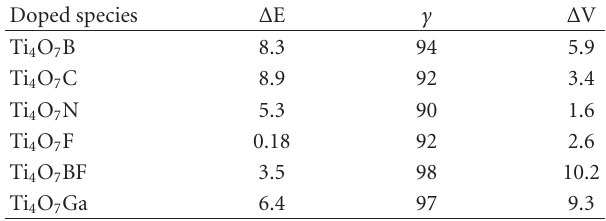
Table 3: Energies (eV) for formation Δ E of several doped species from stoichiometric TiO 2 and the pure element, fully optimized cell parameter γ , (note that α = β = 90 even after full unit cell optimization) and volume change (%) upon